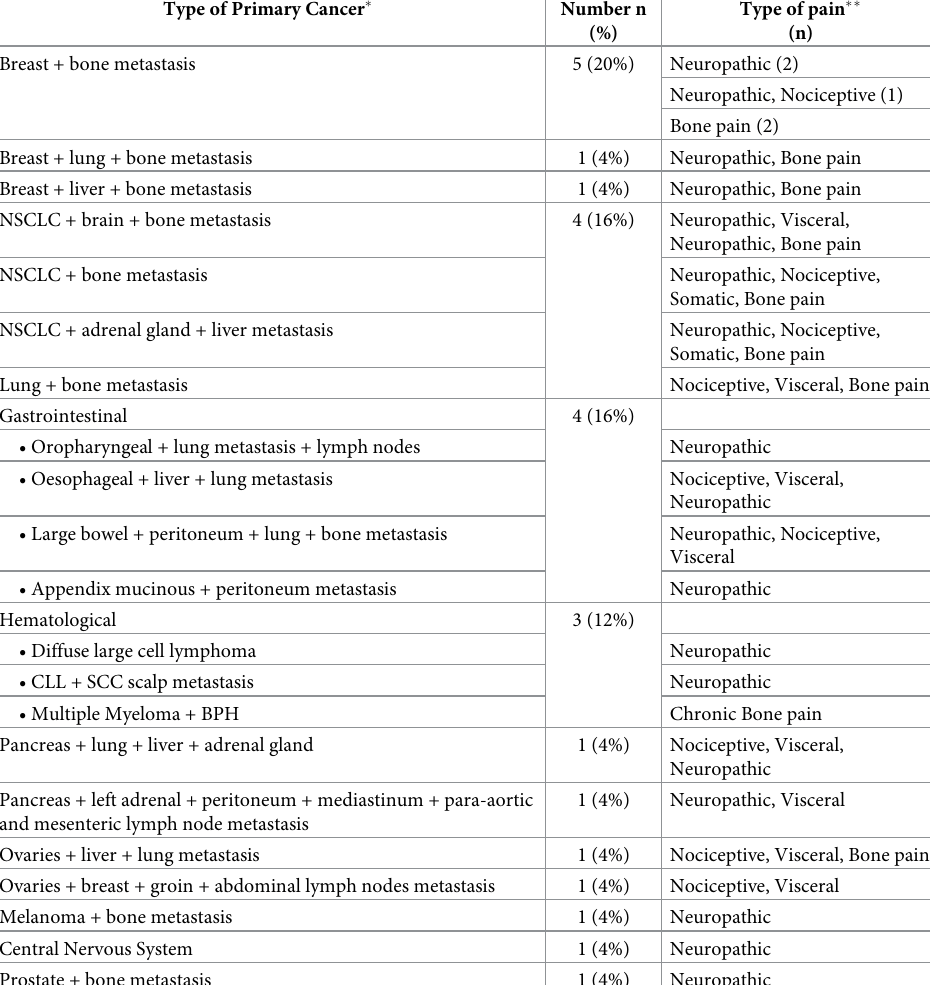
Table 3. Participant baseline clinical characteristics for Stage II (n =